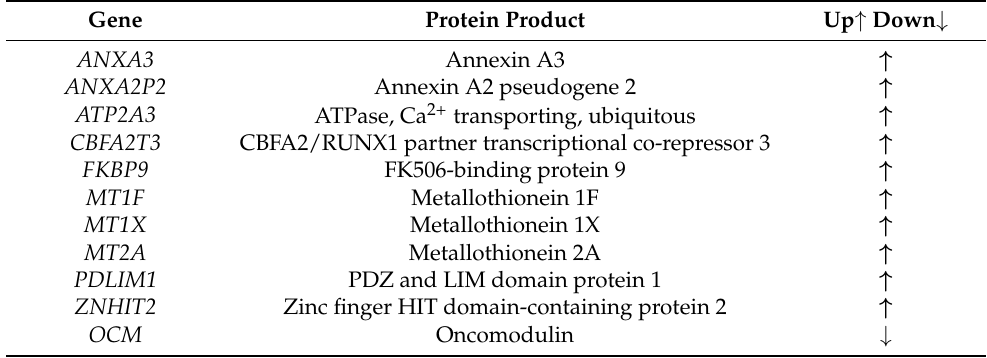
Table 3. Metal ion binding-associated gene signatures in the MCF-7 cells submitted to chronic CdCl 2 exposure